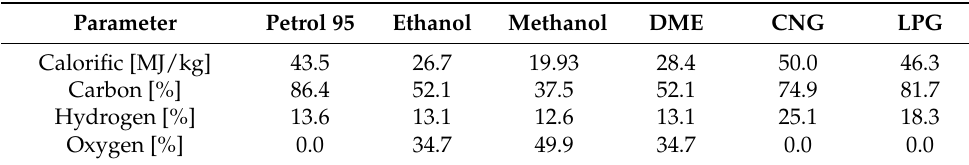
Table 3. Basic parameters of the fuels used in the simulation [189–193]. Parameter